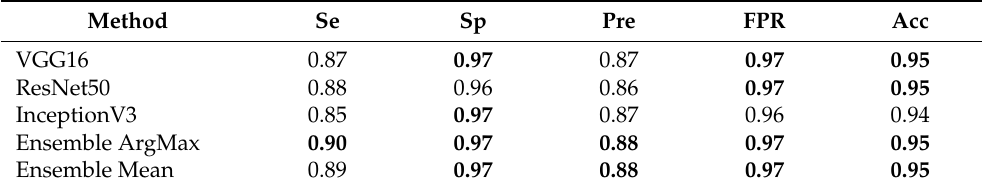
Table 4. Performance parameters for the different classifiers with the previous segmentation of the image by using a SegNet neural network when classifying BCC vs. Nevus. Se: Sensitivity, Sp: Specificity, Pre: Precision, FPR: False Positive Rate, Acc: Accuracy. The highest values are shown in bold numbers.